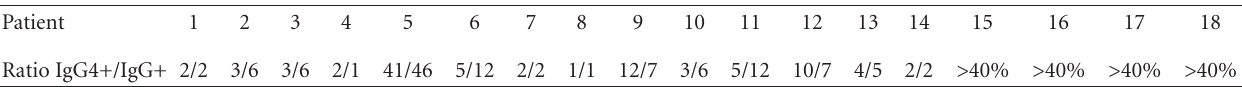
Table 2: Results of immunostaining with anti-IgG and anti-IgG4 antibodies. Ratio > 40% means that plasma cells have not been counted (when >